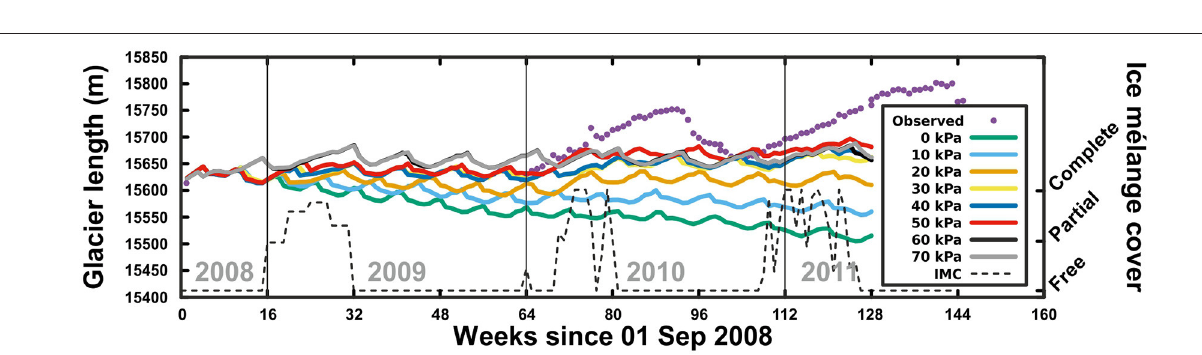
FIGURE 6 | Modeled flowline glacier length for different constant values of ice mélange backstress, with a constant crevasse water depth of 10 m. Magenta dots represent the observed glacier lengths. The dashed line indicates the observed ice mélange coverage (IMC) in the glacier forebay. Week means here 1/48 of a